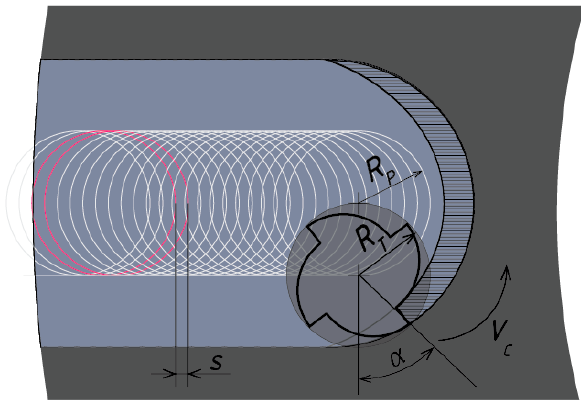
Figure 3. Graphic presentation of trochoidal parameters: s—step of trochoid; RP—radius of the trochoid circle; RT—radius of the milling cutting tool; α —engagement angle.